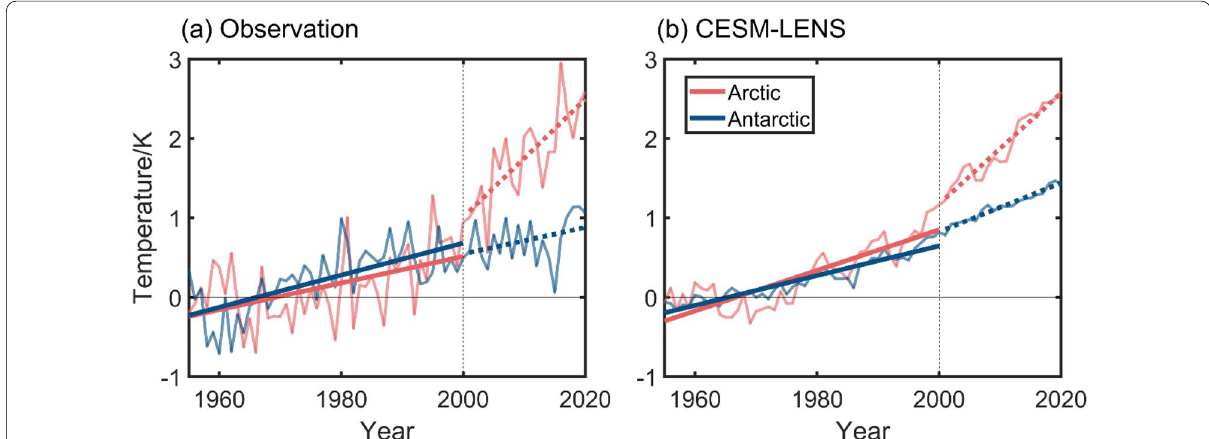
Fig. 1 Time series of surface temperature change ( K ) over the Arctic (red) and the Antarctic (blue) in a Berkeley Earth’s primary product and b CESM-LENS. The temperature change is relative to a monthly climatological mean obtained by averaging over 1951–1980. The thick solid and dashed lines represent linear trends from 1955 to 2000 and from 2000 to 2020,